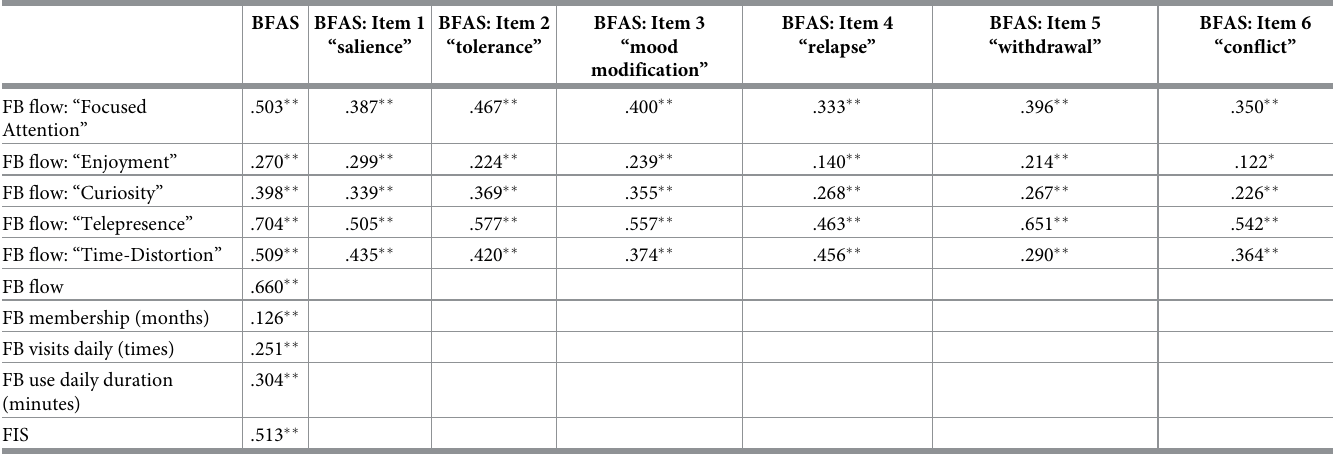
Table 3. Correlations of investigated